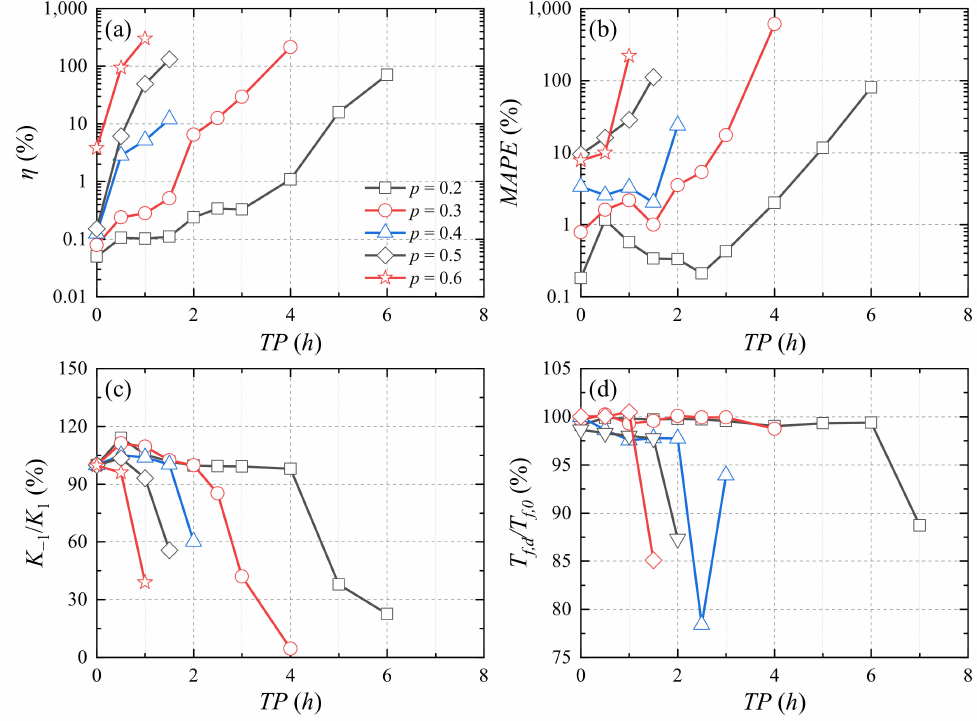
Figure 23. Impact of cyclic load on the response of different axial load ratio ( p ) of RC column during fire exposure: ( a ) cyclic load effect coefficient η ; ( b ) MAPE ; ( c ) stiffness degradation ratio; ( d ) fire resistance time